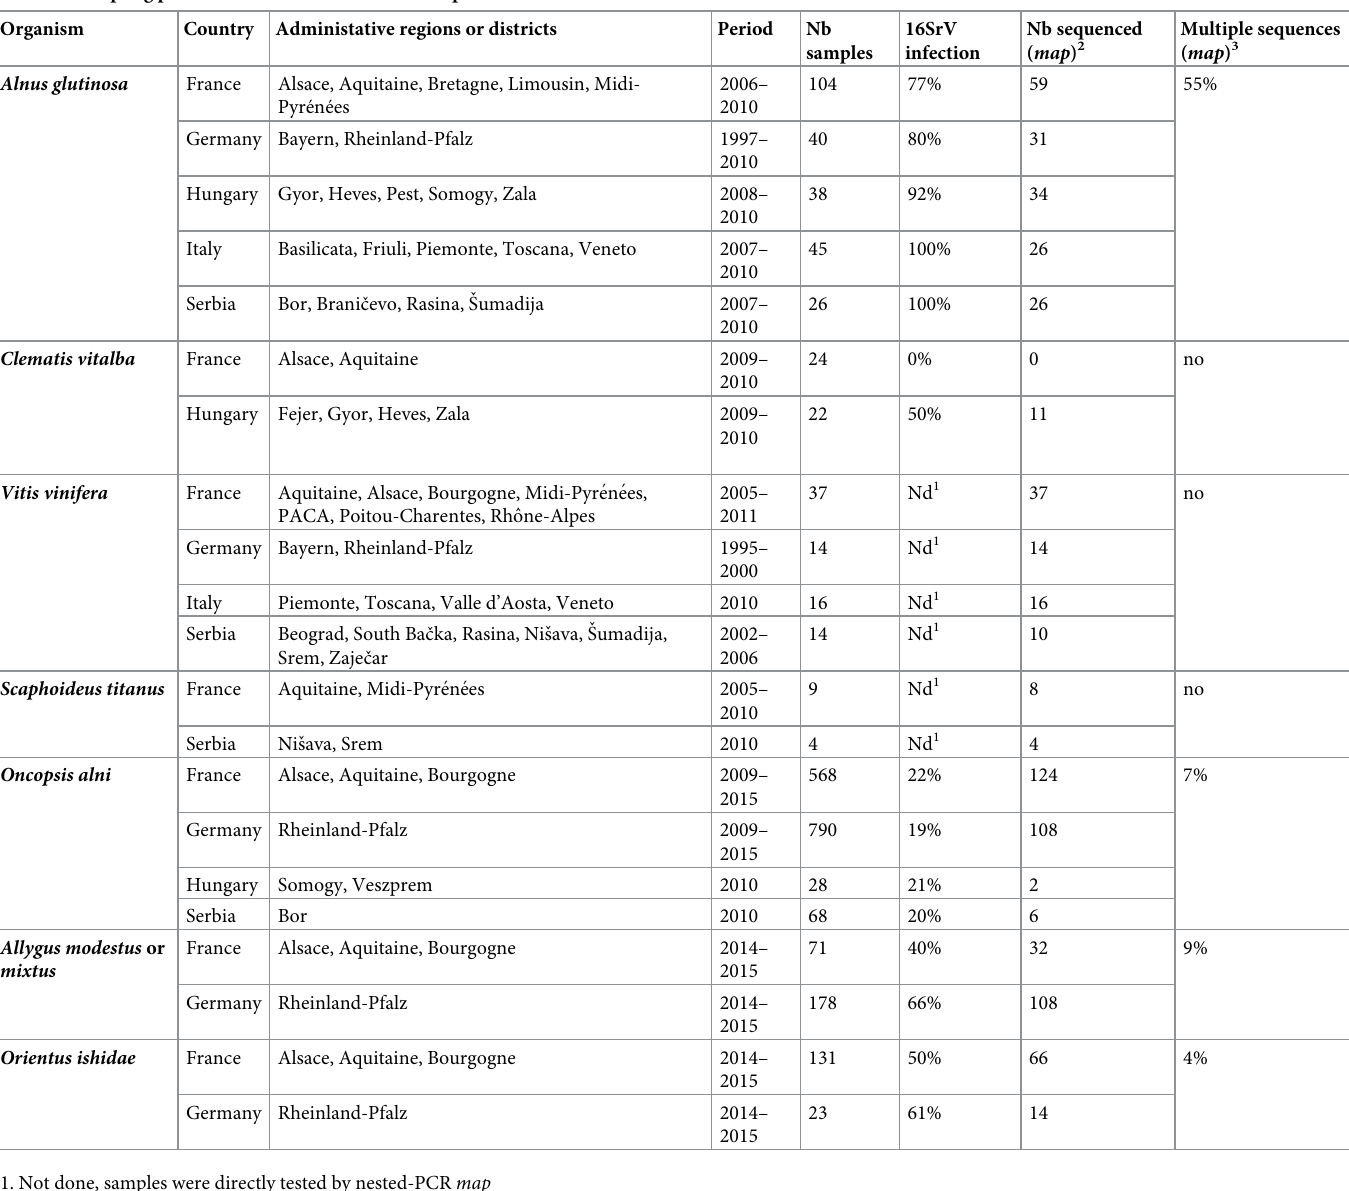
Table 1. Sampling plan and infection status of the